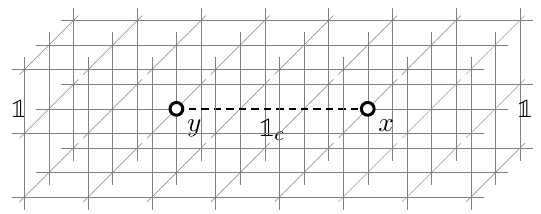
Figure 11. The 0d defects between a trivial string and a 1 c -string.